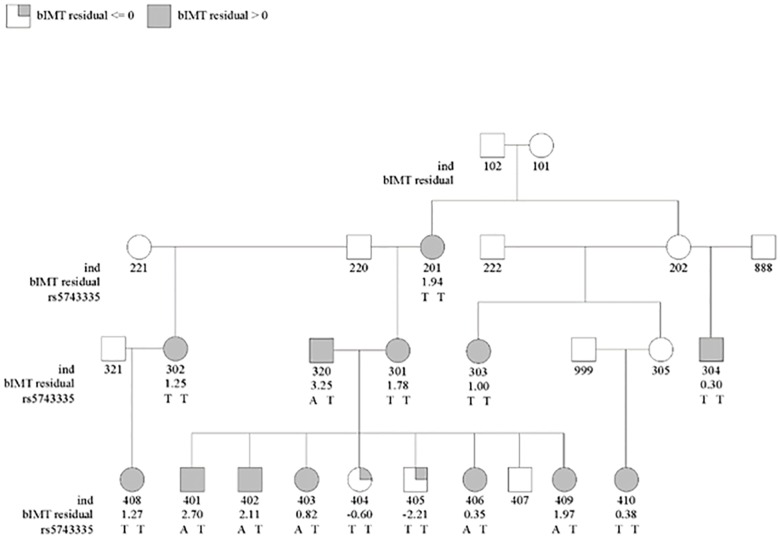
Pedigree of Family 5987 depicting residual bIMT value and rs5743335 genotype, our most significantly associated variant in NOD1.Individuals with residual bIMT value ≤ 0 are shaded gray in the upper right quadrant and individuals with residual bIMT value > 0 are shaded completely gray.